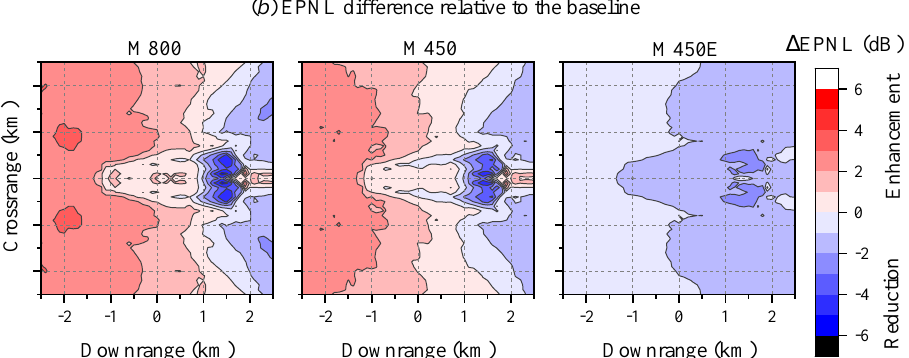
Figure 21. Noise footprint contours, in term of effective PNL (EPNL), corresponding to the aircraft trajectory shown in Figure